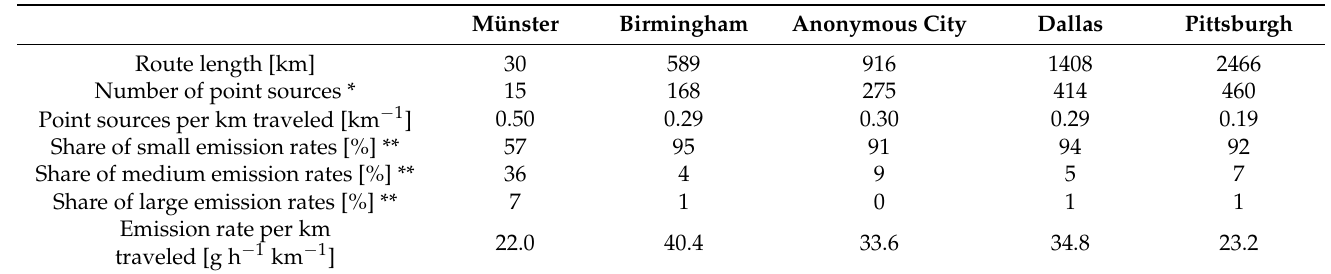
Table 2. Comparison of mobile-collected emission rates (Münster) with mobile-collected data from four cities in the U.S.